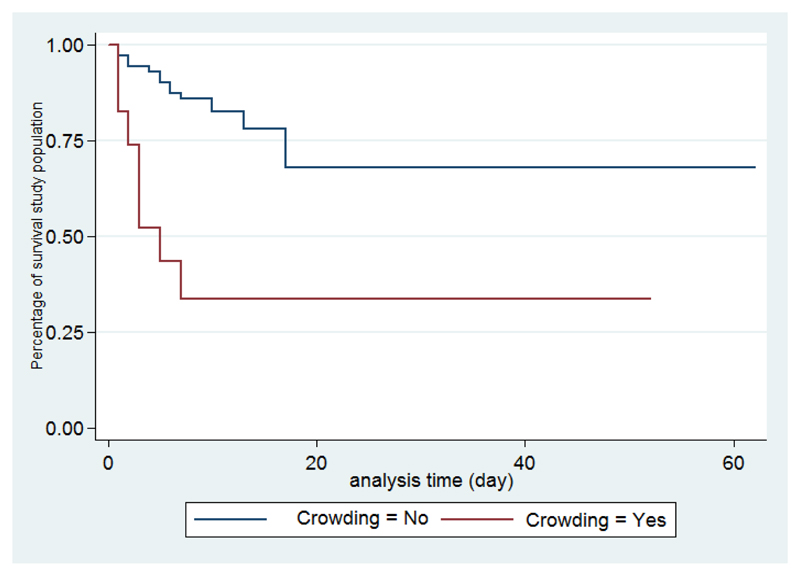
Survival analysis curves according to crowding